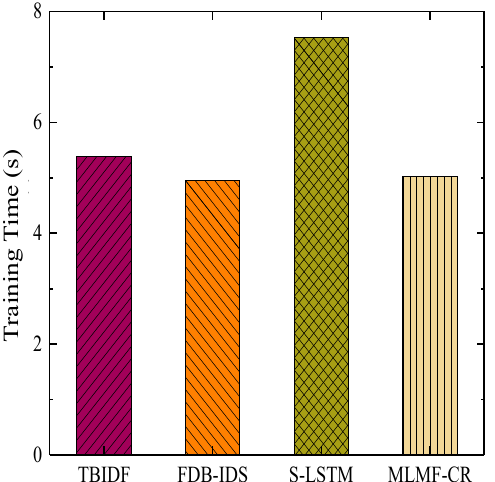
Figure 12. Training time of different fault diagnosis algorithms. Table 3. The basic assignment function m i of each evidence when there is a high degree of conflict.